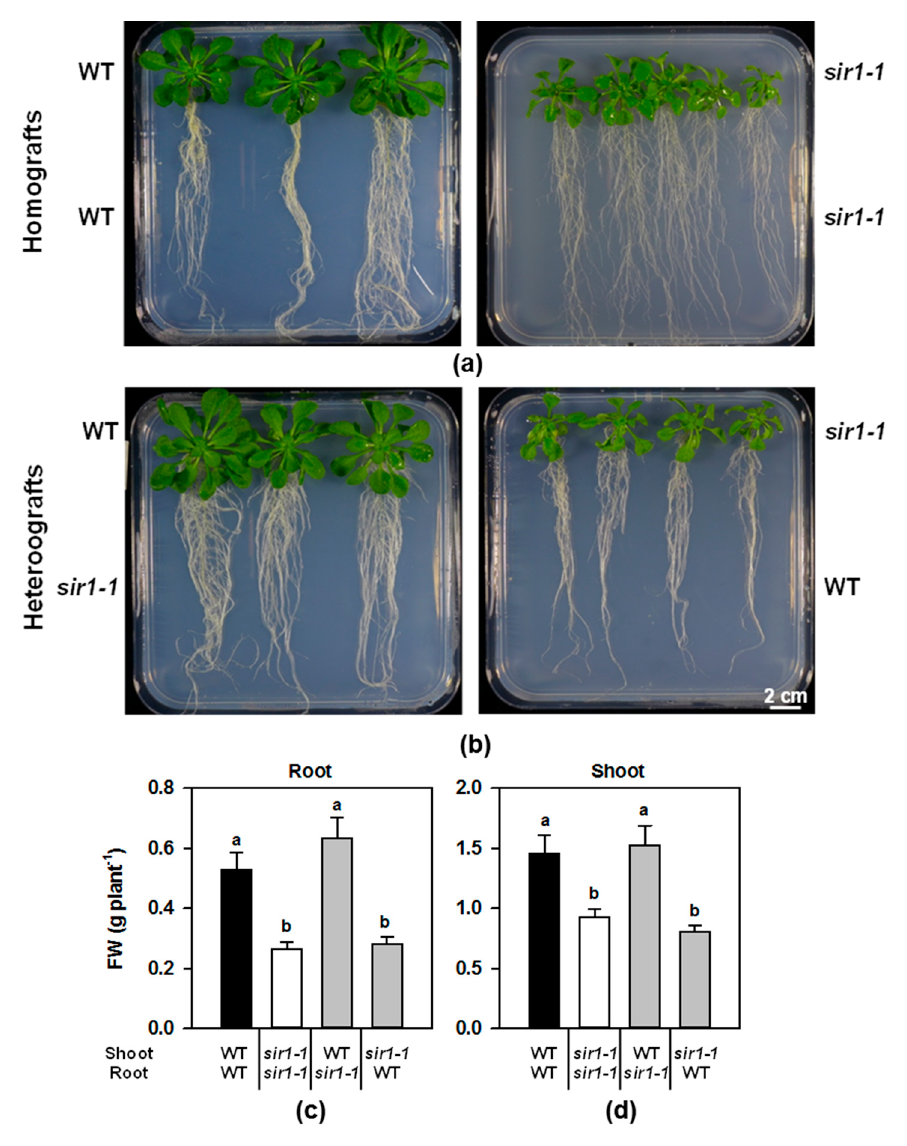
Figure 1. Phenotypic analysis of micrografted plants. ( a , b ) Phenotype of grafted plants five weeks after germination; selected representatives are shown for the four different grafting combinations. ( c , d ) Fresh weight (FW) of roots and shoots. Data represent mean and standard error and are modified according to [11] ( n > 15). Different letters indicate statistically significant differences; p < 0.05, ANOVA followed by Dunn ´ s test; FW = fresh